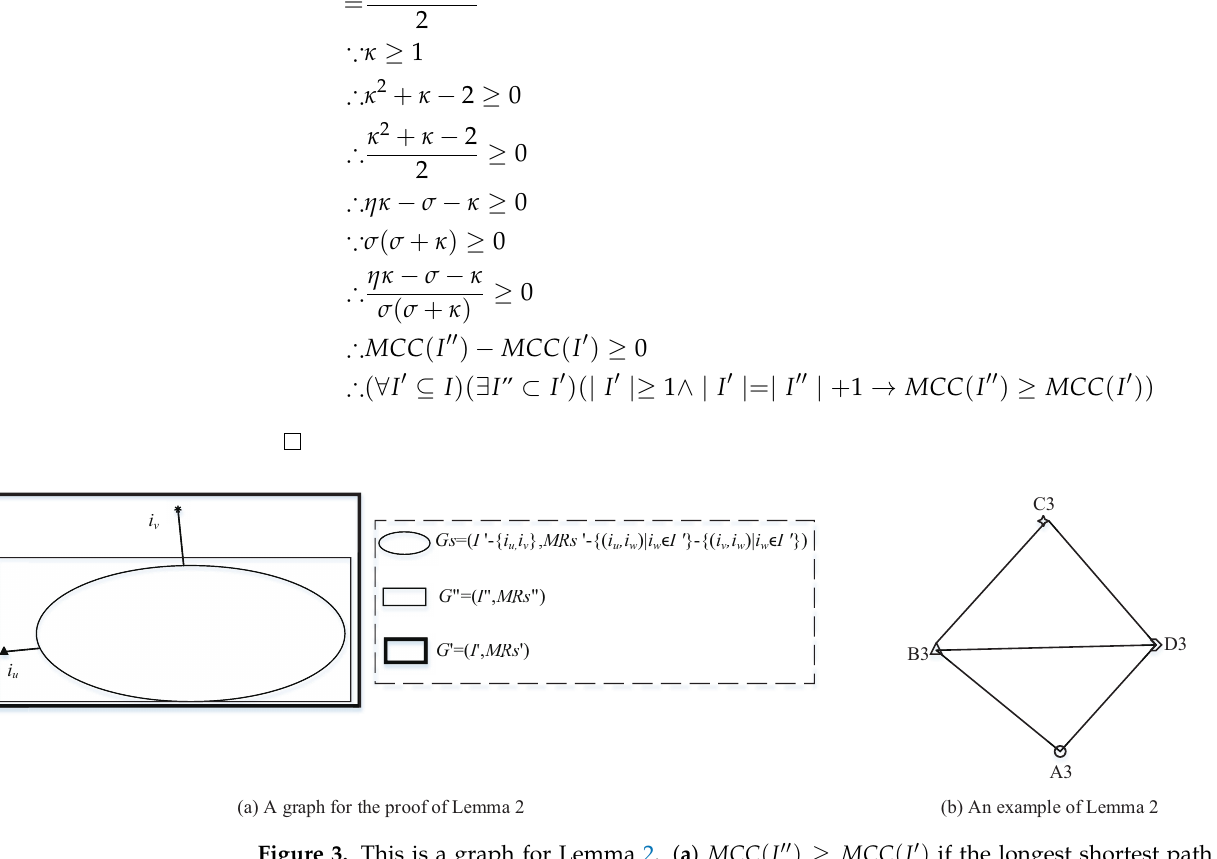
Figure 3. This is a graph for Lemma 2. ( a ) MCC ( I (cid:48)(cid:48) ) ≥ MCC ( I (cid:48) ) if the longest shortest path in I (cid:48) is sp ( i u , i v )] and MCC ( I (cid:48)(cid:48) ) = CC ( I (cid:48)(cid:48) , i u ) . ( b ) MCC ( { A 3, B 3, D 3 } ) ≥ MCC ( { A 3, B 3, C 3, D 3 } ) but MCC ( { A 3, B 3, C 3 } ) < MCC ( { A 3, B 3, C 3, D 3 } )